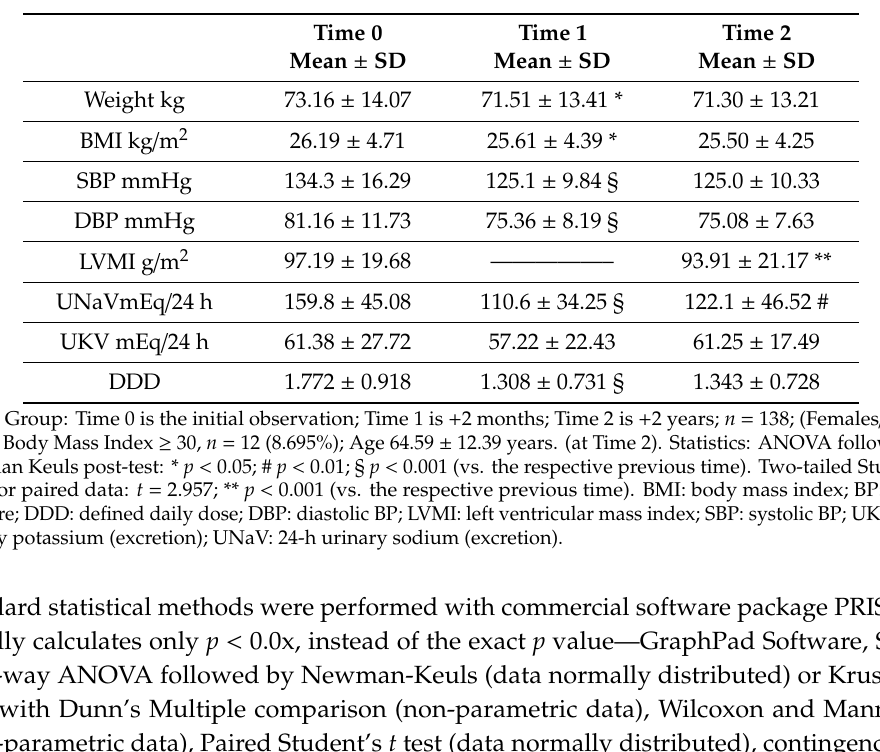
Table 1. Descriptive statistics of the whole patient